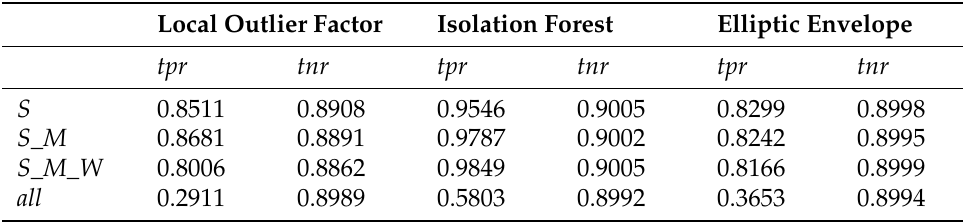
Table 20. Extended BankSim dataset outlier detection based fraud